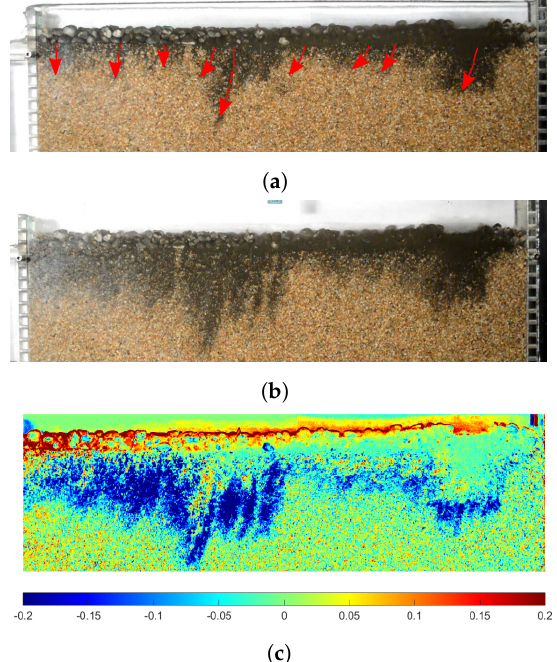
Figure 4. Effect of subsurface flow on increased infiltration of copper concentrate into sediment substrate. ( a ) Infiltration of copper concentrate into the sediment substrate. Bridging steady state in the sand substrate, with d s = 1.9 mm and Q sub / Q sur > 0; ( b ) Increase of infiltration depth due to decrease of subsurface level water. Bridging steady state in the sand substrate with d s = 1.9 mm and without surface and subsurface flows; ( c ) False color of image image ( a ) minus image ( b